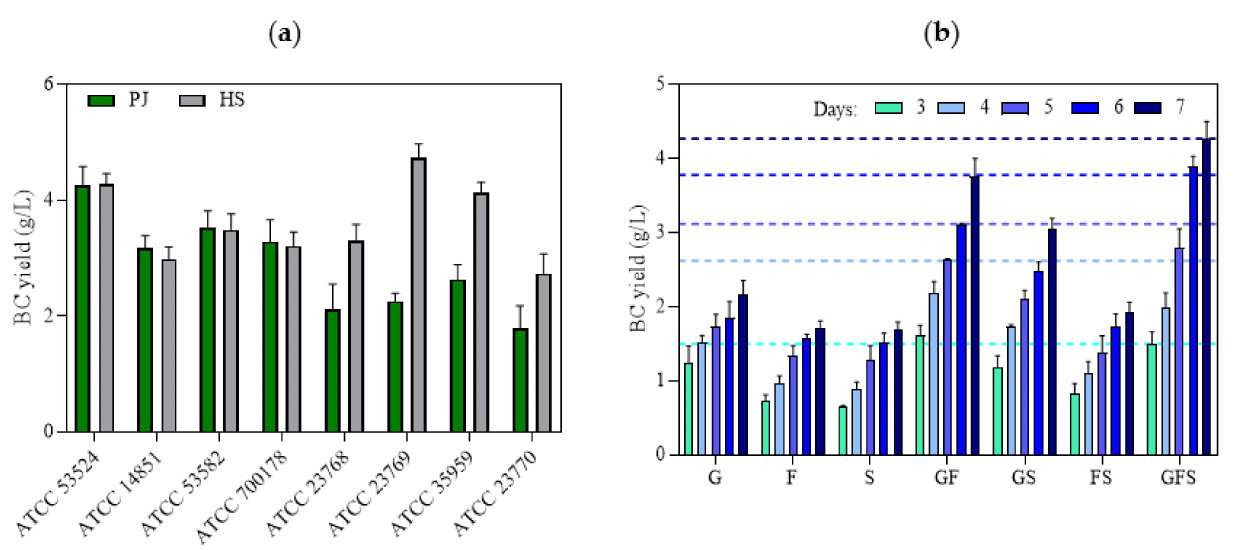
Figure 3. ( a ) BC yields of different K. xylinus strains in PJ and HS media after 7 days of cultivation; ( b ) BC yields of K. xylinus ATCC 53524 in HS medium with the addition of sugars at the same concentration as in PJ medium in the following days of cultivation. Data are presented as a mean ± standard error of the mean (SEM): G—glucose; F—fructose; S—sucrose. Horizontal lines in ( b ) indicate the BC yield of K. xylinus ATCC 53524 in PJ medium in the following days of